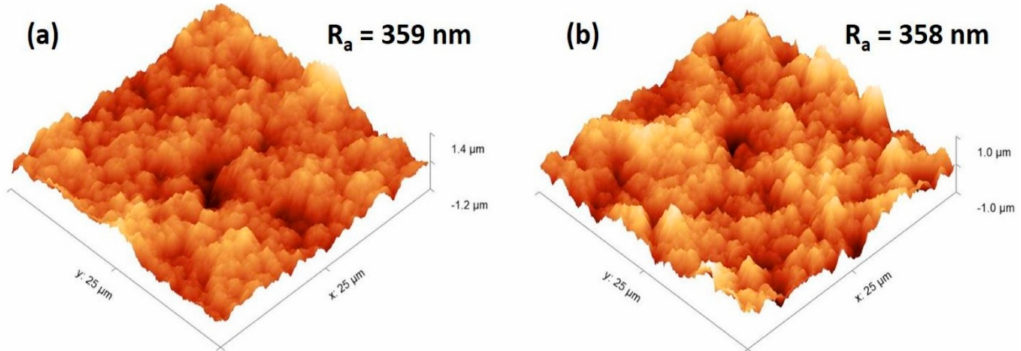
Figure 4. 3-Dimensional atomic force microscope (AFM) image of the ( a ) superhydrophobic aluminum surface with Coating A and ( b ) superhydrophobic aluminum surface with Coating B.